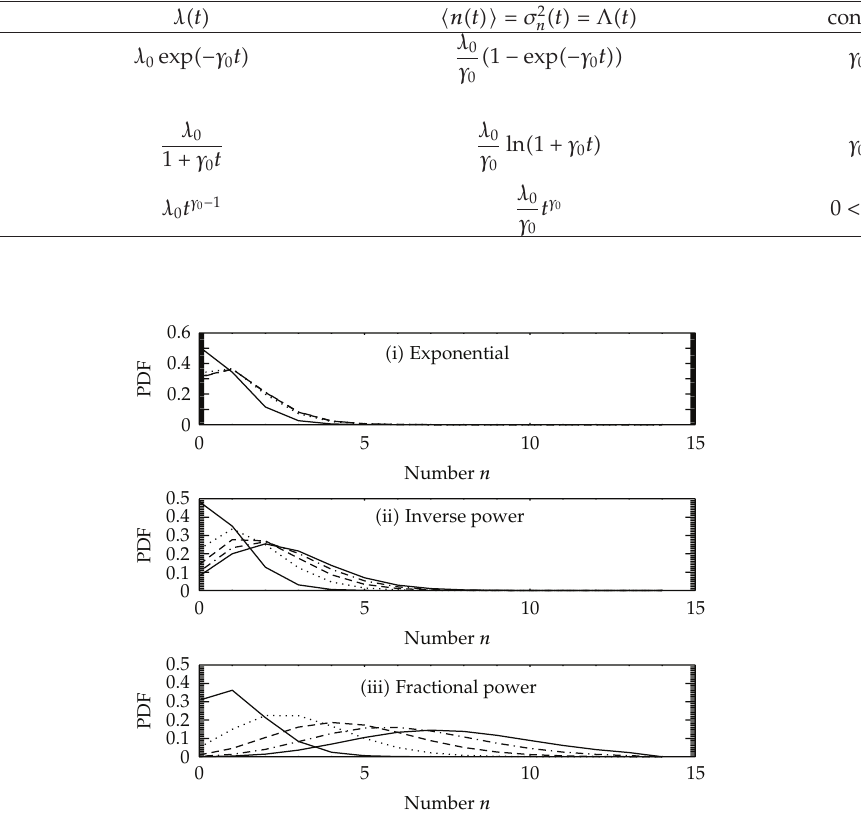
Figure 1: Time dependence of p (cid:3) n,t (cid:4) in (cid:3) 2.2 (cid:4) for three relaxation functions of λ (cid:3) t (cid:4) in Table 1: (cid:3) i (cid:4) an exponential function, (cid:3) ii (cid:4) an inverse power function, and (cid:3) iii (cid:4) a fractional power function; the values of parameters are λ 0 (cid:7) 1 ,γ 0 (cid:7) 0 . 85. The pdf profiles are depicted for t (cid:7) 1 (cid:3) solid line (cid:4) , t (cid:7) 3 (cid:3) dotted line (cid:4) , t (cid:7) 5 (cid:3) dashed line (cid:4) , t (cid:7) 7 (cid:3) dash-dotted line (cid:4) , and t (cid:7) 9 (cid:3) dash-dotted line (cid:4)